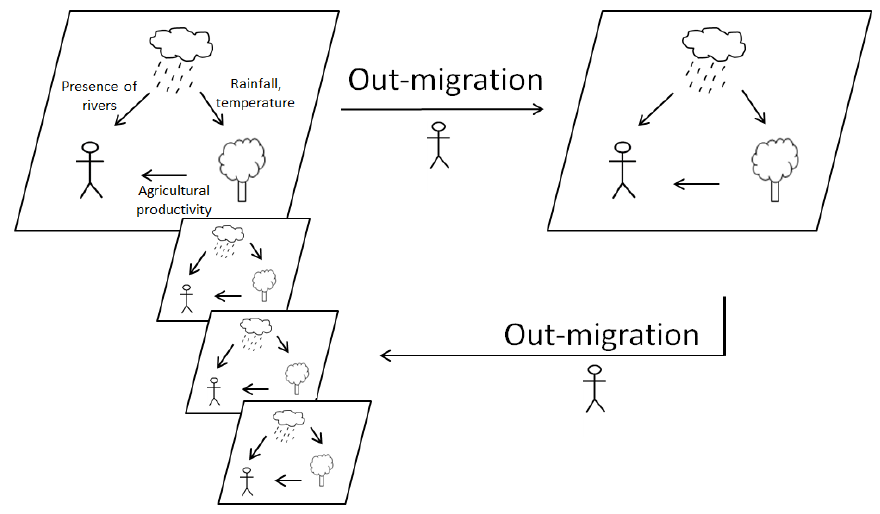
Fig. A1.15 Diagram drafted for the ABM described by Wu et al. (2011); agents do not make explicit return decisions, but migrate from region to region and can thereby visit a region again at some point in the future